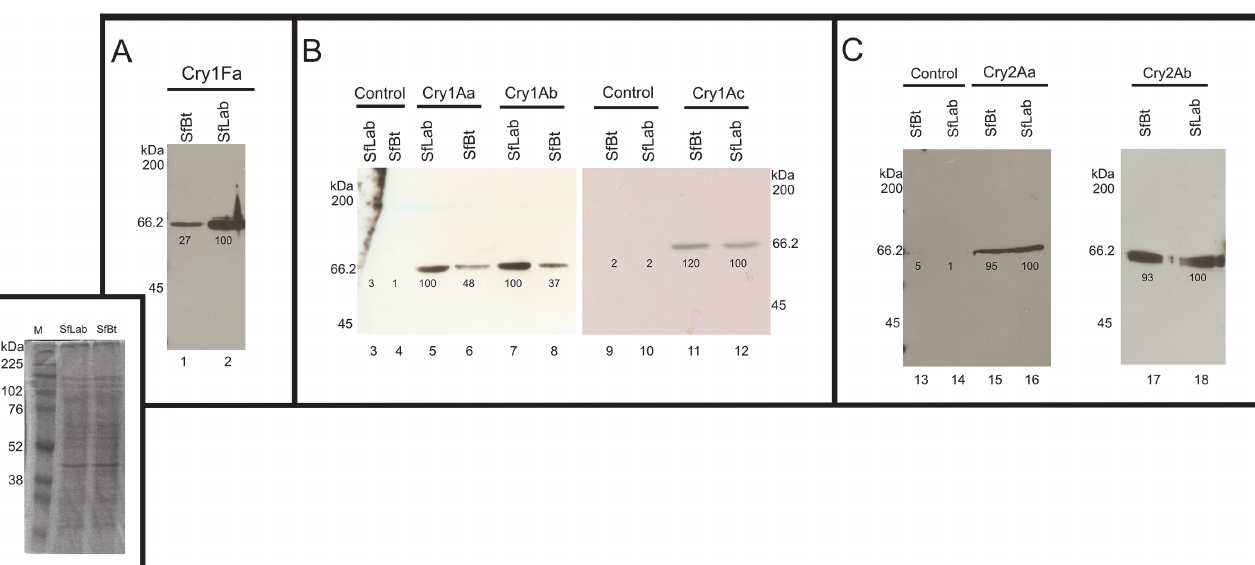
Fig 1. Analysis of binding of Cry toxins to BBMV from SfLab and SfBt populations. Panel A, Binding of Cry1Fa: Lane 1, binding of Cry1Fa to SfBt; Lane 2, binding of Cry1Fa to SfLab: Panel B, Analysis of binding of Cry1A toxins: Lanes 3 and 10, control of BBMV from SfLab without toxin incubation; Lanes 4 and 9, control of BBMV from SfBt without toxin incubation; Lane 5, binding of Cry1Aa to SfLab; Lane 6, binding of Cry1Aa to SfBt; Lane 7, binding of Cry1Ab to SfLab; Lane 8, binding of Cry1Ab to SfBt; Lane 11, binding of Cry1Ac to SfBt; Lane 12, binding of Cry1Ac to SfLab. Panel C, binding of Cry2A toxins: Lane 13, control of BBMV from SfBt without toxin incubation; Lane 14, control of BBMV from SfLab without toxin incubation; Lane 15 binding of Cry2Aa to SfBt; Lane 16, binding of Cry2Aa to SfLab; Lane 17, binding of Cry2Ab to SfBt; Lane 18, binding of Cry2Ab to SfLab. Binding of biotinylated toxins (10 nM) to BBMVs from S . frugiperda SfLab and SfBt populations was performed as described in material and methods. Numbers under the bands represent the percentage of each band on the blot calculated after scanning optical density of the bands with ImageJ program and using one band of similar size in the gel as 100% reference. Insert: Gel 12% SDS PAGE with BBMVs prepared from SfLab and SfBt populations. Lane 1, Rainbow molecular marker (GE); Lane 2, 10 μ g of BBMV SfLab; Lane 3, 10 μ g of BBMV SfBt